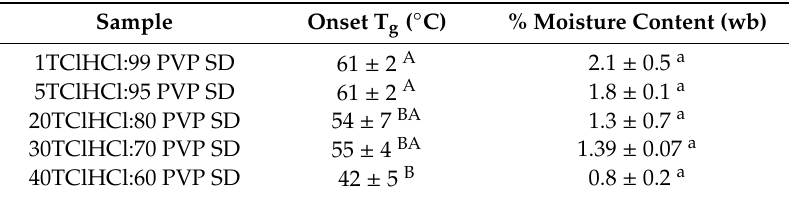
Table 2. Onset glass transition temperatures (T g ) and moisture contents of amorphous solid dispersions with di ff erent TClHCl:PVP ratios immediately following lyophilization.